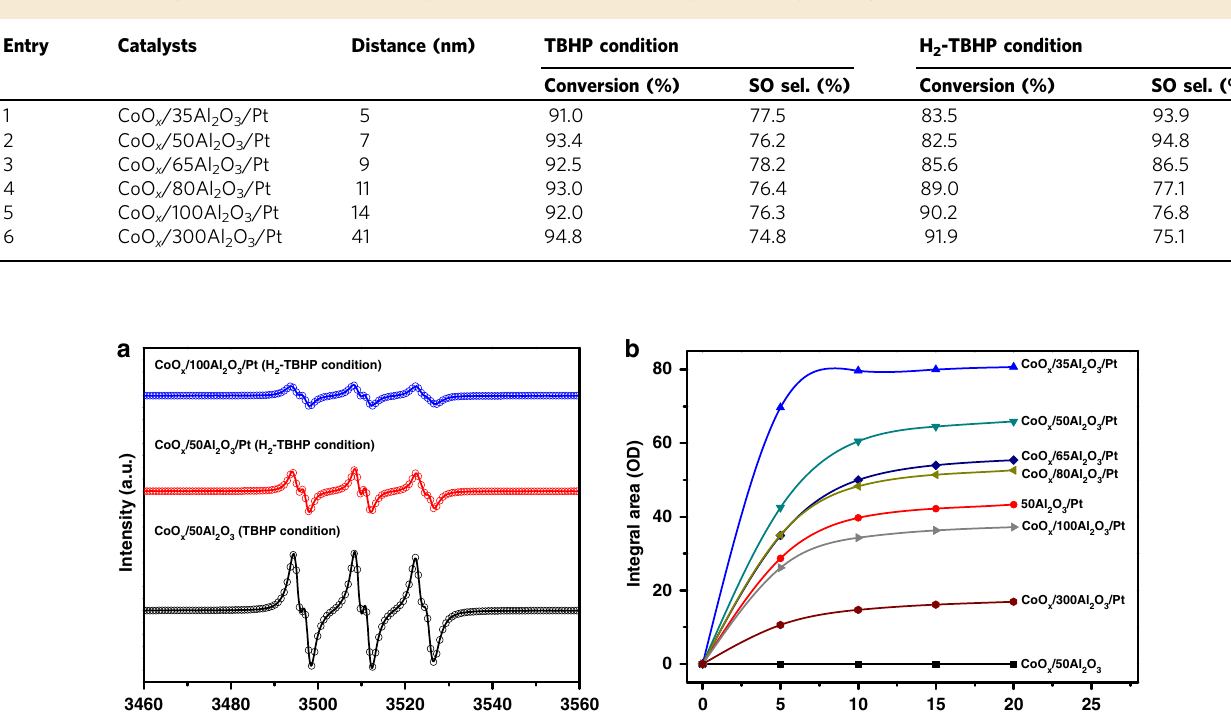
Table 2 Catalytic performances of the catalysts with different Al 2 O 3 cycles for styrene epoxidation reaction.